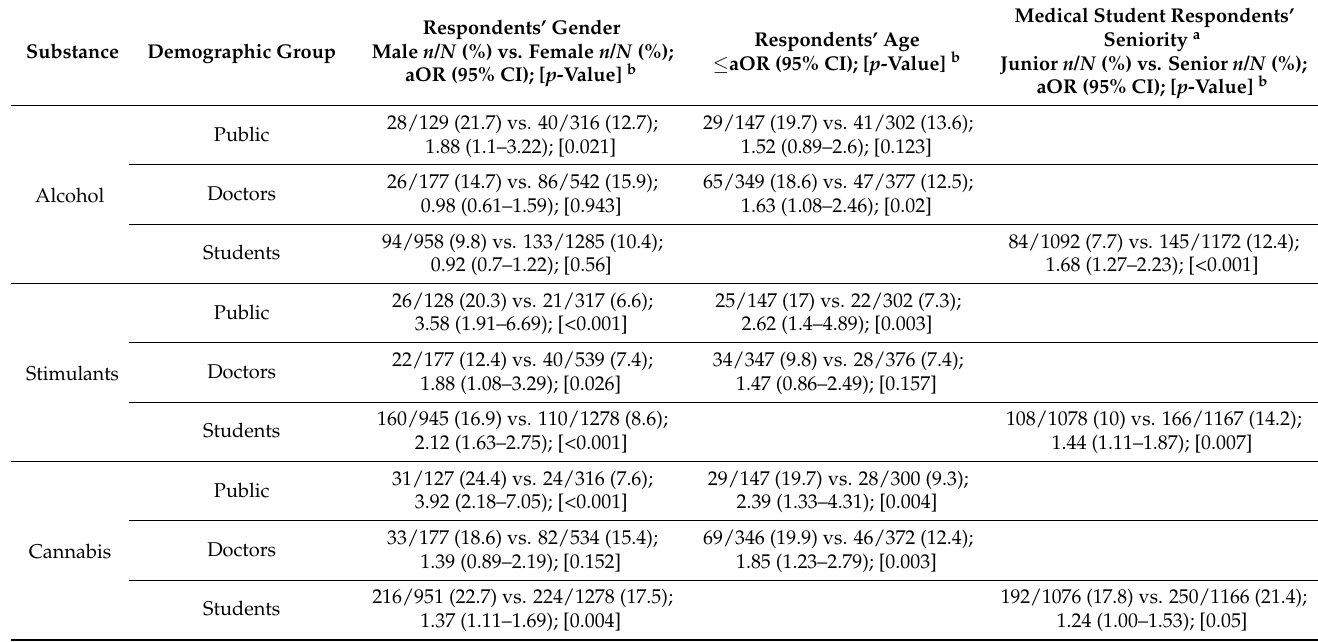
Table 4. Adjusted Analysis of Participants’ Demographics on their Opinions for the Acceptability for Alcohol/Substance Misuse by a Medical